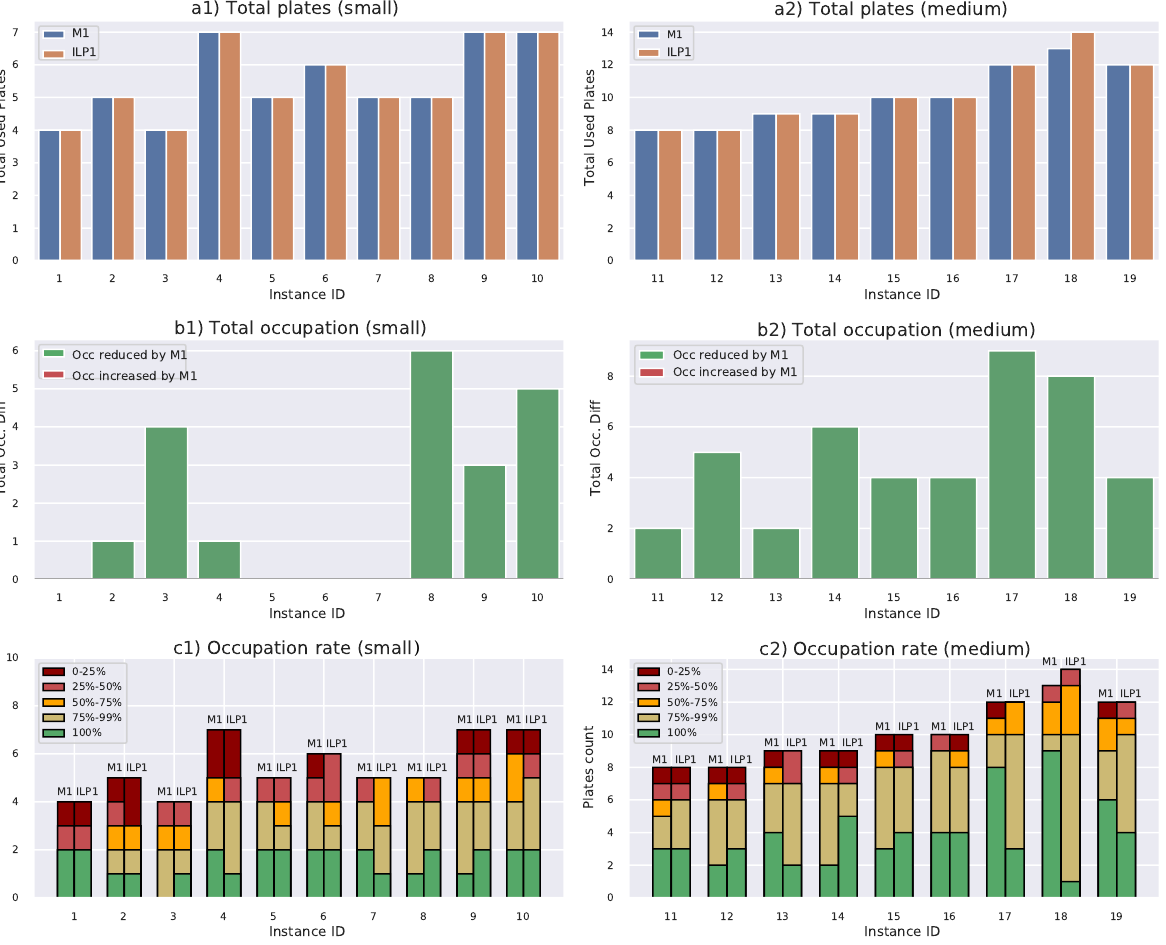
Figure 9. Comparison of M1 and ILP1 on small and medium size